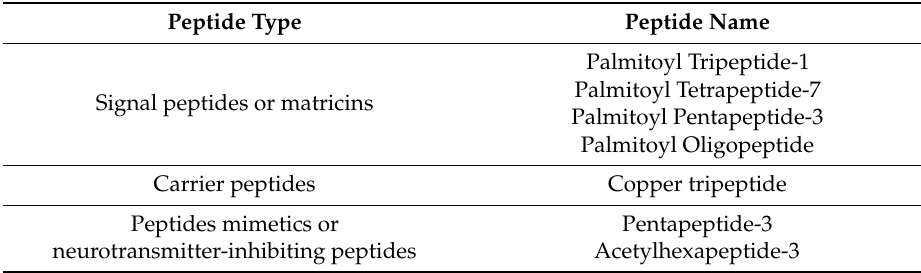
Table 1. Topically used